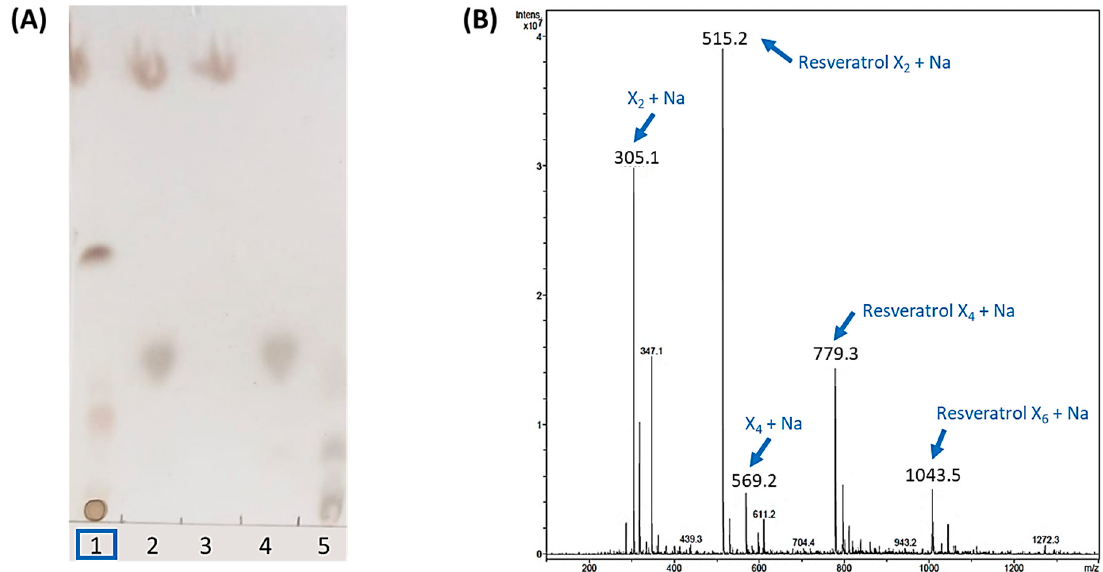
Figure 1. Analysis of the standard resveratrol glycosylation reaction catalyzed by rXynSOS-E236G glycosynthase using X 2 F as the donor. ( A ) Thin layer chromatography (TLC). Lane 1: sample of the glycosylation mixture, containing resveratrol, X 2 F, the catalyst and the reaction products. Lane 2: negative control with resveratrol and X 2 F and no catalyst. Lane 3: negative control containing only the resveratrol acceptor. Lane 4: negative control consisting of only the X 2 F donor. Lane 5: standards’ mixture with xylose, xylobiose, xylotriose and xylotetraose. ( B ) ESI-MS spectrum (positive mode). The m / z of ions corresponding to the Na + adducts of the resveratrol glycosides, xylobiose and xylotetraose are indicated with blue arrows. Resveratrol was not detected in the positive mode spectrum but was clearly visible in the negative mode spectrum (Figure S1).